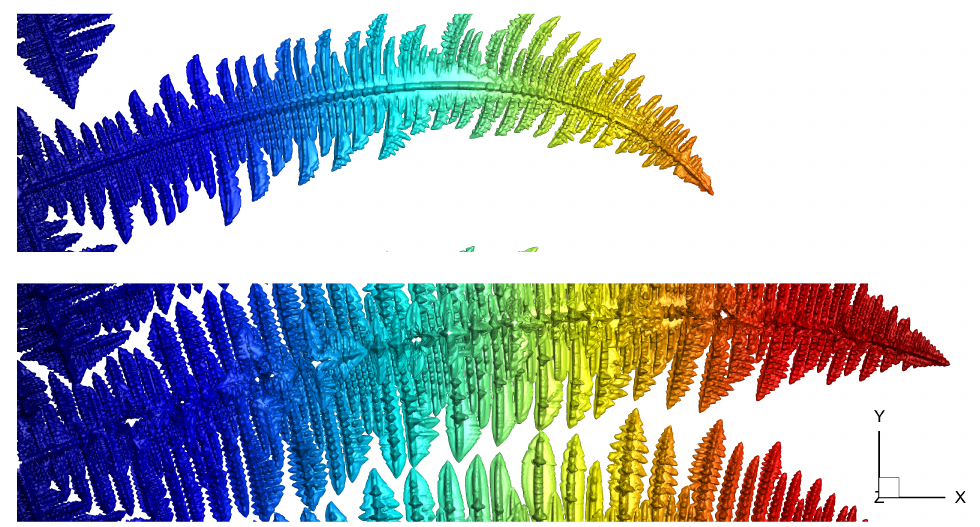
Figure 6. 3D surfaces showing the microstructure of a dendrite grown under a constant force in a thin sample simulation ( top ) and a 3D simulation ( bottom